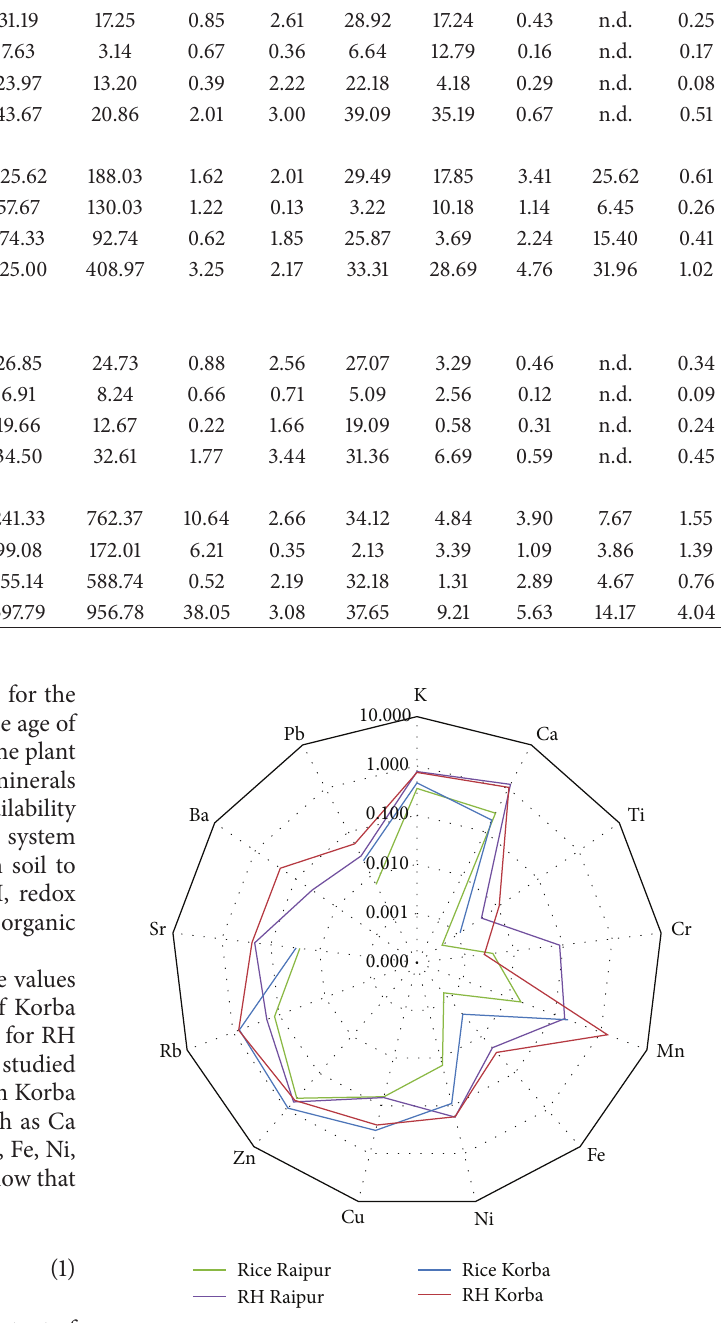
Figure 4: Transfer factors calculated for rice and rice husk samples with respect to soil samples from Korba and